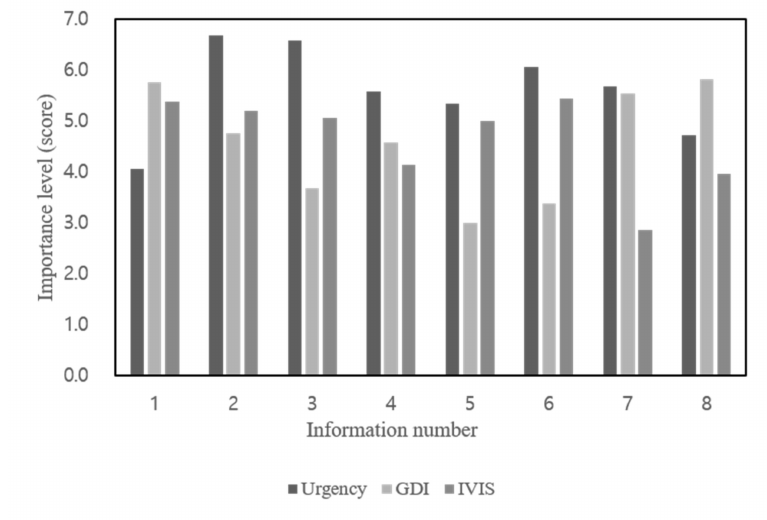
Figure 3. Importance level for each